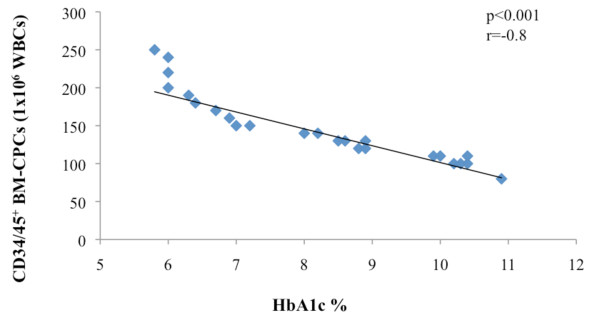
We observed a significantly inverse correlation between the frequency of CD34/45+ BM-CPCs and levels of HbA1C in total of IHD patients with diabetes (n = 40).